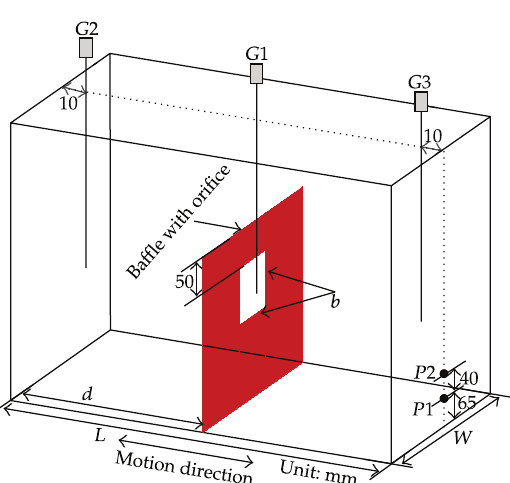
Figure 5: Schematic diagram of wave gauges, pressure transducers and slosh suppression ba ffl e arrange-